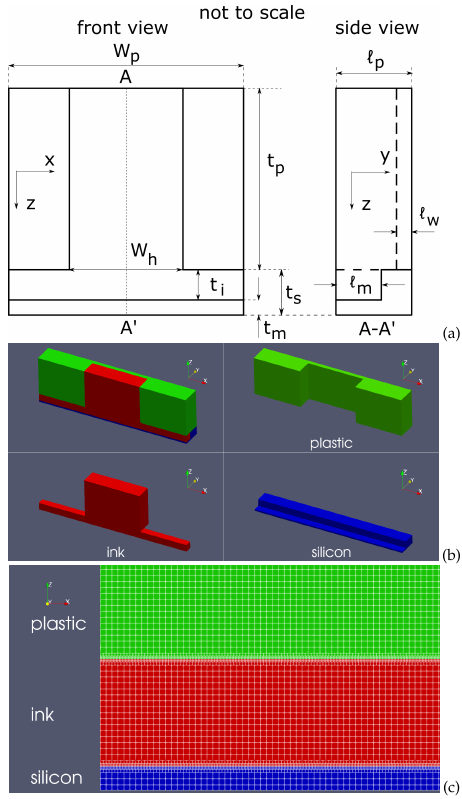
Figure 8. Geometry and mesh. ( a ) schematic showing main dimensions: W = width, t = thickness, Figure8. Geometryandmesh. (a)schematicshowingmaindimensions: W =width, t =thickness, ‘ = length,subscripts‘ i ‘=ink,‘ p ‘=plastic,‘ s ‘=silicon,‘ m ‘=MEMS,‘ w ‘=plasticside-wall;forthese (cid:96) = length, subscripts ‘ i ’ = ink, ‘ p ’ = plastic, ‘ s ’ = silicon, ‘ m ’ = MEMS, ‘ w ’ = plastic side-wall; for simulations, W h is varied from 0.25 to 1.5 mm, whilst the following parameters are held constant: W p = 2mm, t p = 0.5mm, t s = 0.11mm, t m = 0.02mm, ‘ p = 0.25mm, ‘ w = 0.05mm, ‘ m = 0.09mm; (b)thesimulationdomainiscomposedofthreematerials: blue=silicon,red=ink,green=plastic;(c) meshonsymmetryplaneat y = 0,showingrefinementprovidedby snappyHexMesh .